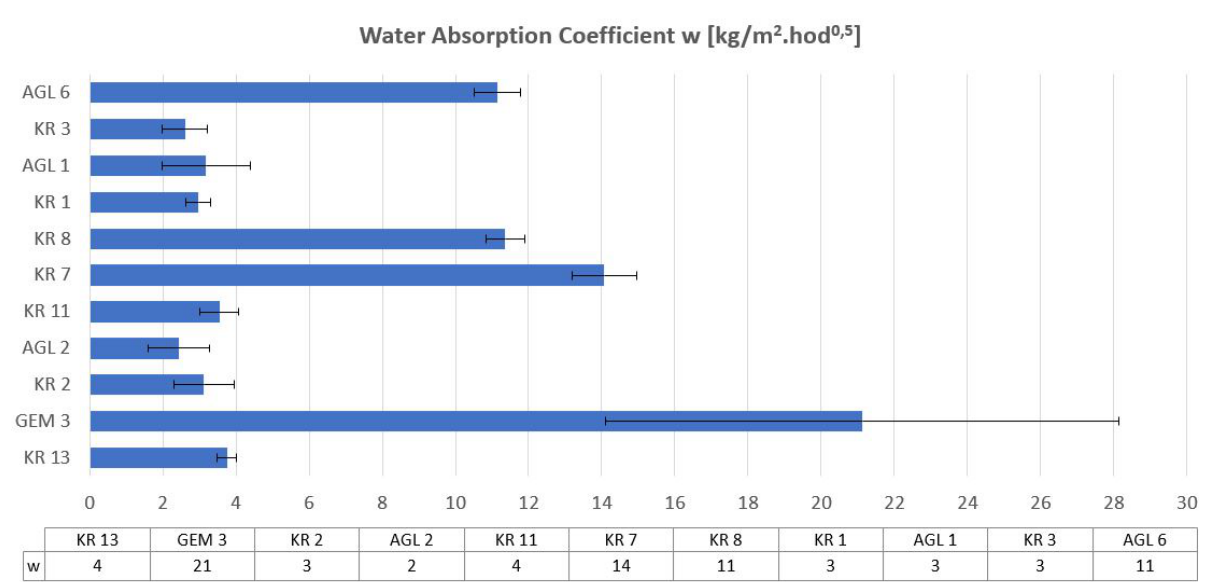
Figure 4. Water Absorption Coefficient.